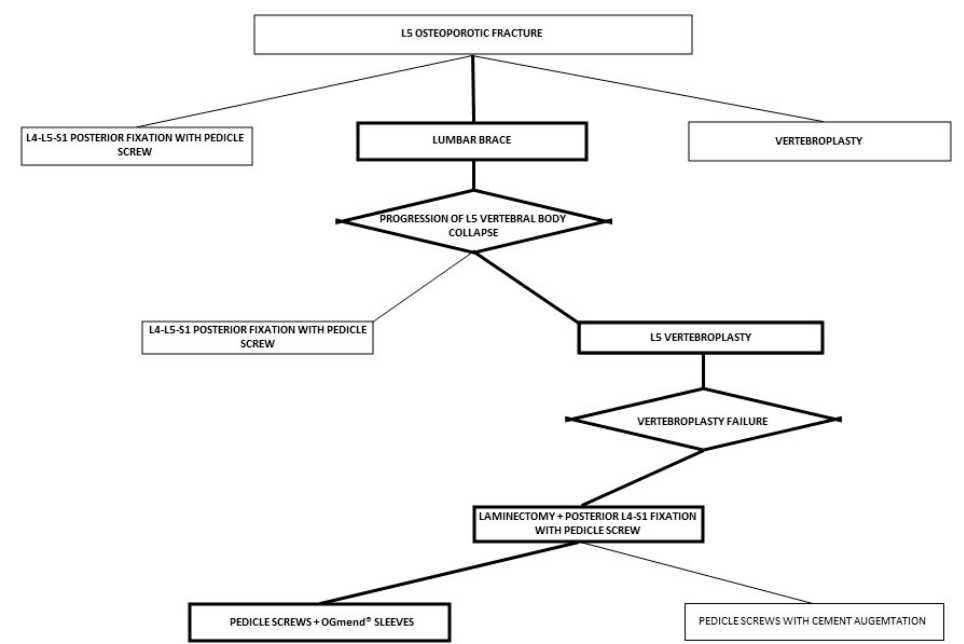
Figure 6. Decisional approach summary. The bold black line highlights the decisional approach chosen compared to the thin black line, which shows the alternative strategies that were not taken.